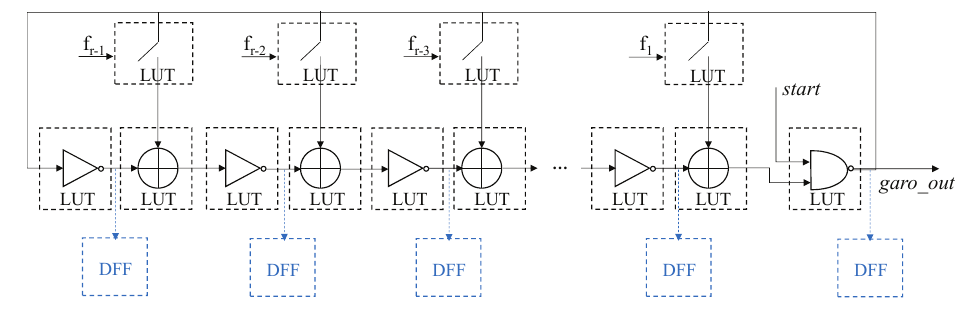
Figure 4: The implementation of a GARO on